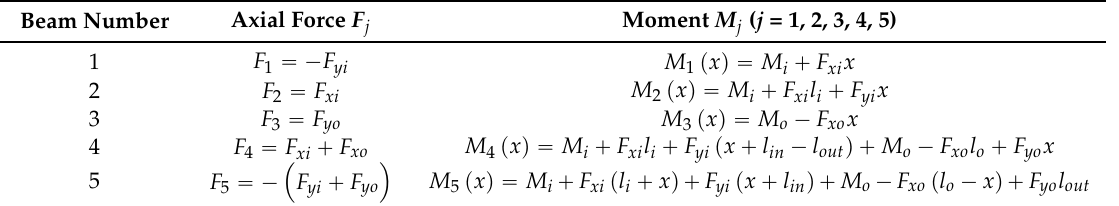
Table A1. The axial force and moment of each beam on the